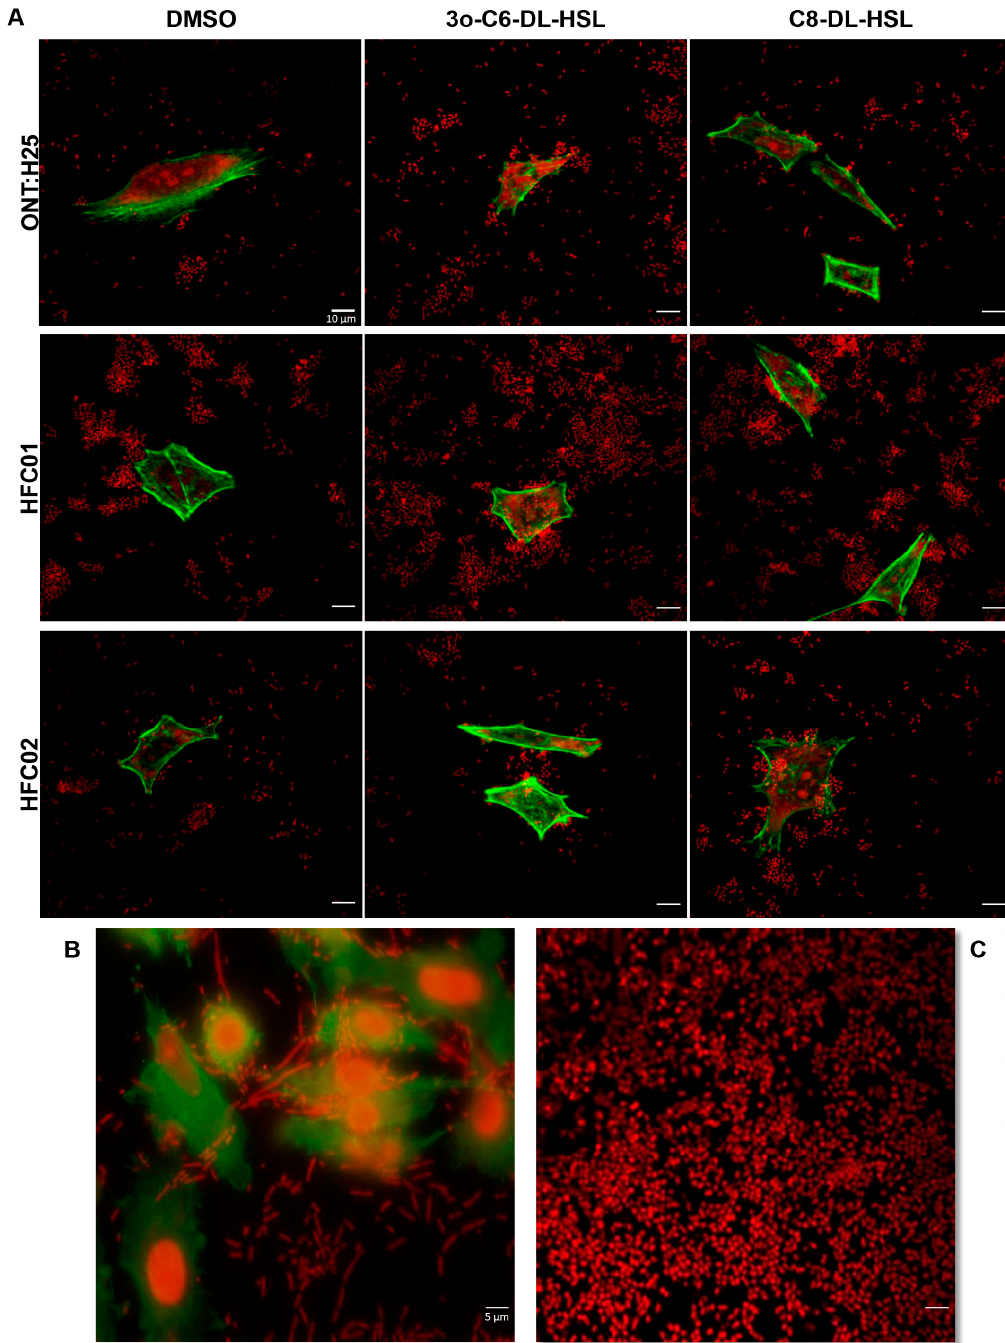
Figure 5. ( A ) Fluorescent actin staining assay of ONT:H25, HFC01 and HFC02 in HeLa cells in Dulbecco’s Modified Eagle Medium (DMEM) supplemented with DMSO, 3O-C6-DL-HSL and C8-DL-HSL after 6 h of incubation at 37 °C. ( B ) Long filament-like morphology displayed by bacteria in the presence of HeLa cells. ( C ) Bacteria in the absence of HeLa cells. HeLa cells were stained with Alexa Fluor–Phalloidin (green) and nucleic acids were stained with Propidium Iodide (red). ( A ), 630× magnification; ( B , C ), 1000× magnification.